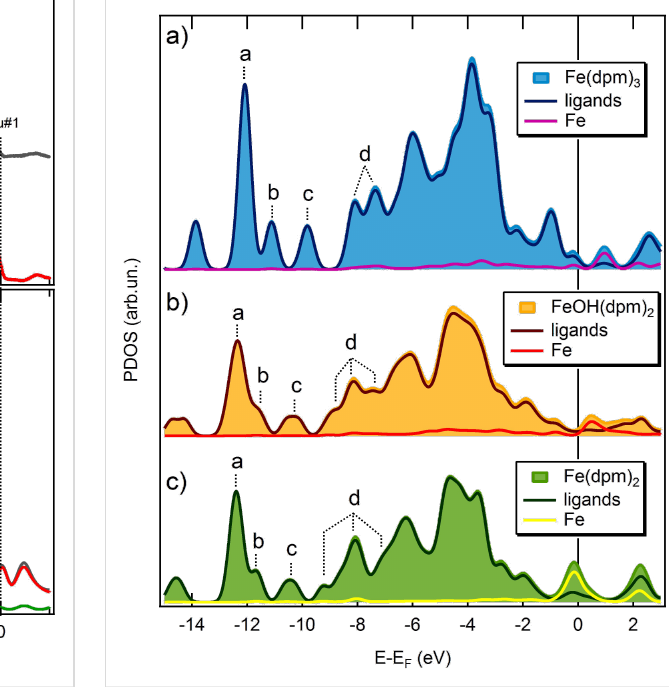
Figure 3: Projected DOS of the molecules in Fe(dpm) 3 @Au(111) (a), FeOH(dpm) 2 @Au(111) (b), and Fe(dpm) 2 @Au(111) (c), in which further separation of PDOS coming from the Fe ion and the ligands is